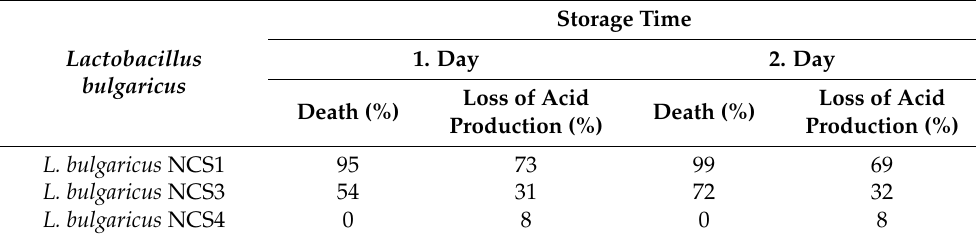
Table 3. Stability of individual species of L. bulgaricus during cryopreservation in liquid nitrogen (data from Smittle et al., 1972